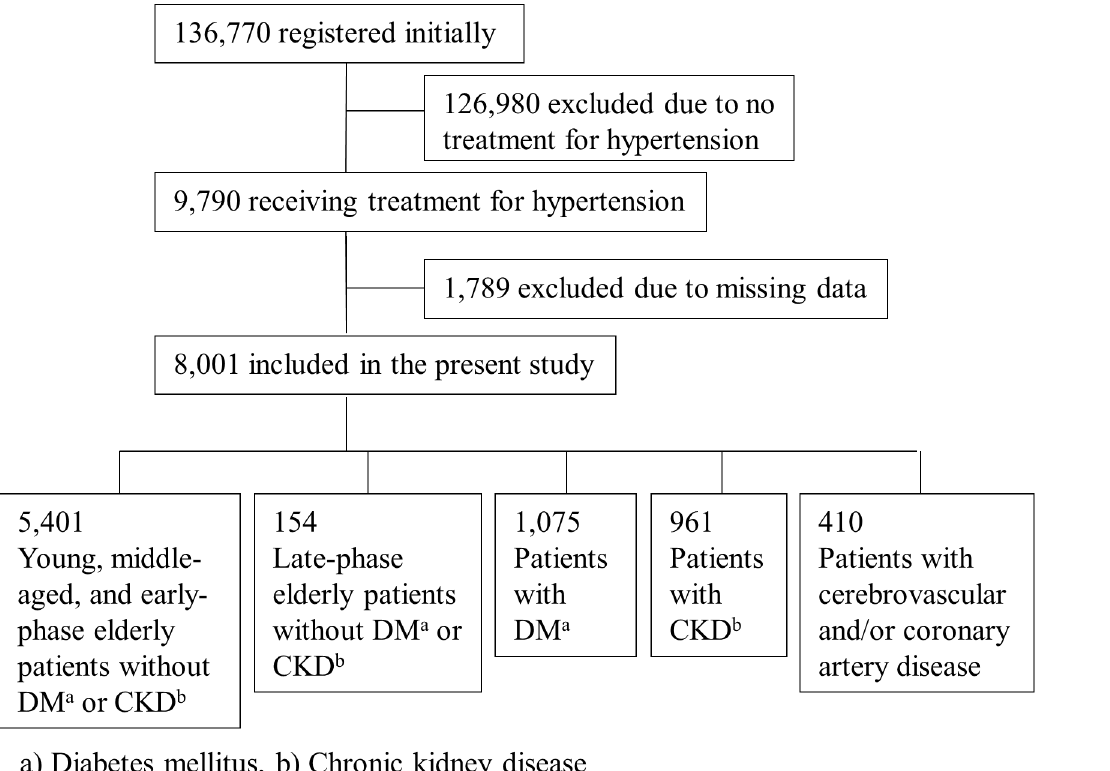
Fig 1. Patients ’ registration and